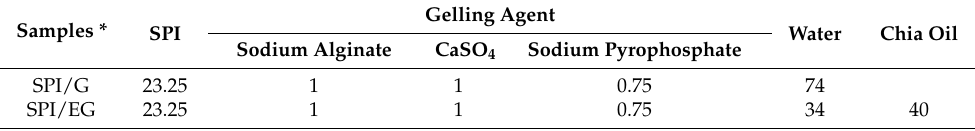
Table 1. Formulation (%) of oil-free SPI gels (SPI/G) and SPI emulsion gels with chia oil (SPI/EG). Samples